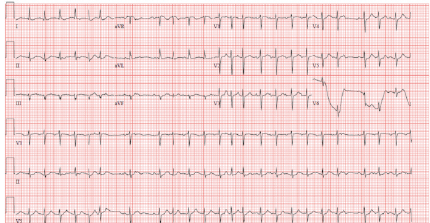
Figure 1: Initial ECG on presentation to the emergency department demonstrating tachycardia with an irregularly irregular rhythm and no obvious p waves consistent with atrial fibrillation with a rapid ventricular response.